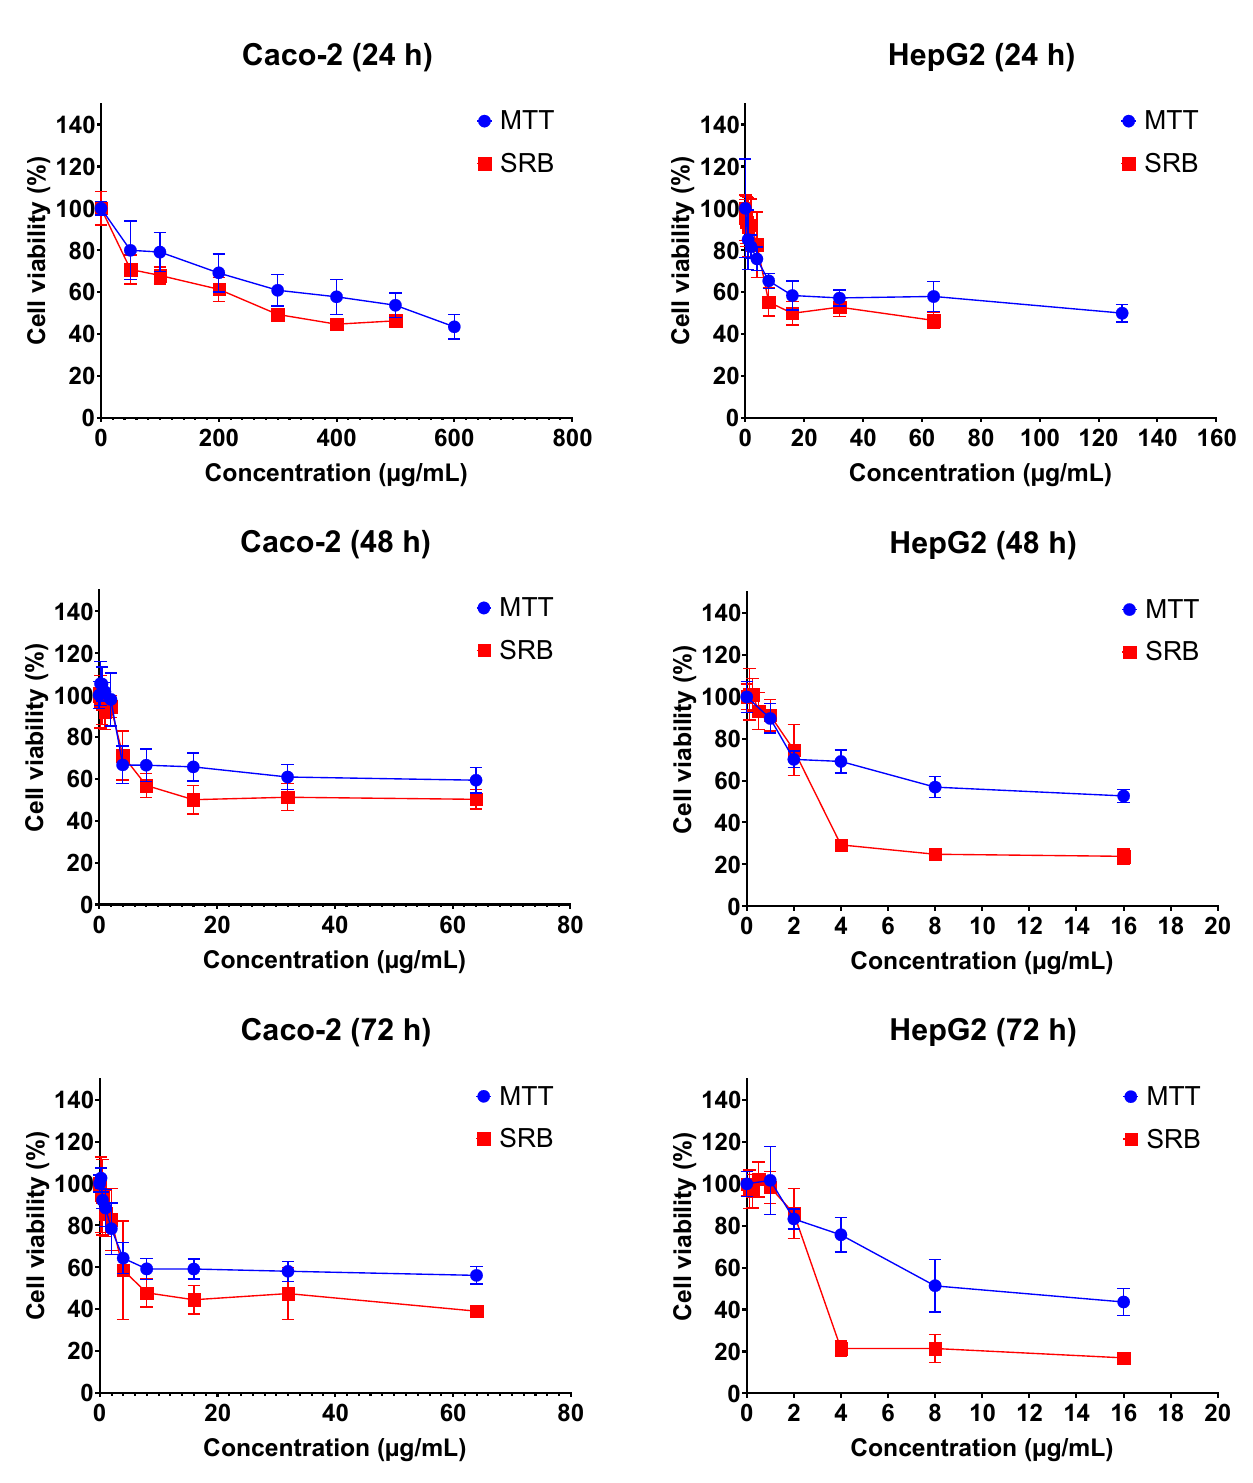
Figure 1. Concentration – response curves for the individual 24 h, 48 h and 72 h treatments with FB1 in Caco-2 and HepG2 cells. Data (three technical replicates and three independent repetitions) are expressed as mean ± SD.